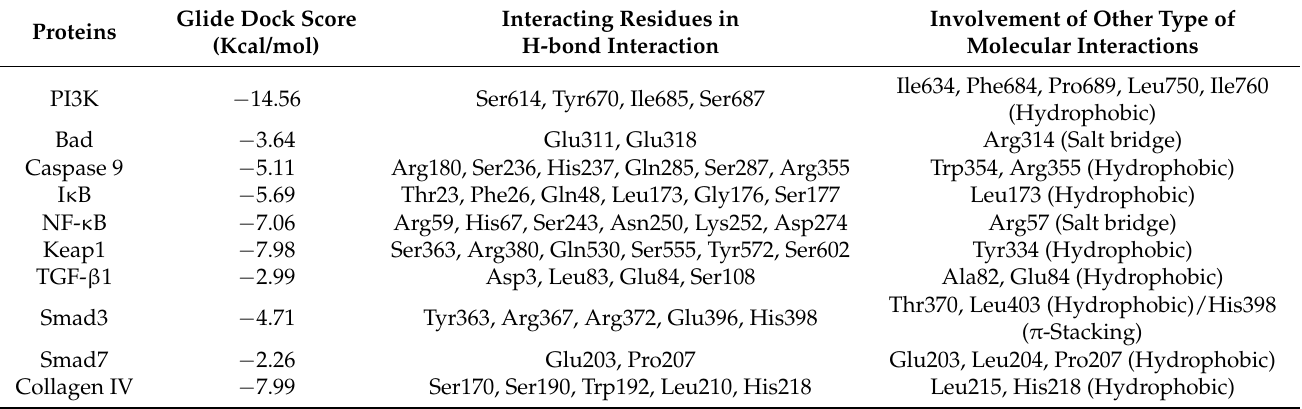
Figure 14. In silico molecular docking analysis revealed several types of possible molecular interactions between Myr and signal proteins, such as PI3K ( a ), Bad ( b ), caspase 9 ( c ), I κ B ( d ), NF- κ B ( e ), Keap1 ( f ), TGF- β ( g ), Smad3 ( h ), Smad7 ( i ), and collagen IV ( j ). Table 4. XP-Glide score and interacting residues of different bioactive signaling receptors/proteins in molecular docking analysis with Myr.